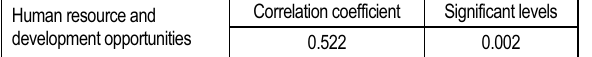
Table 8. Spearman correlation coefficient test Correlation coefficient Significant levels Human resource and development opportunities 0.522